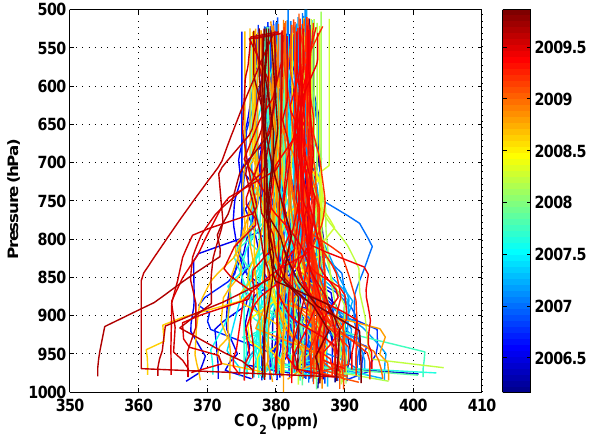
Fig. 11. The curves in this figure show the effect of the choice of a priori profile, and the effect of smoothing by the averag- ing kernels for data measured over the Lamont TCCON site. Plots show the ACOS-GOSAT adjustment to the ensemble pro- ( x a1 − x c ) j , blue), the TCCON adjustment to file ( P j h j ( a 1 − u ) T j ( x a2 − x c ) j = 0, green), the ensemble profile ( P j h j ( a 2 − u ) T j